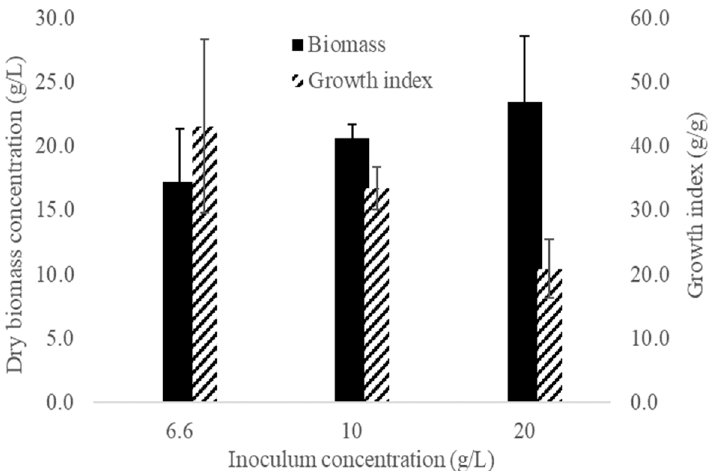
Figure 3. Dry biomass concentration and growth index obtained after 14 days using different inoculum concentrations. Black bars: dry biomass concentration (g/L). Striped bars: growth index (g/g). Error bars indicate the standard deviation of three independent replicates.